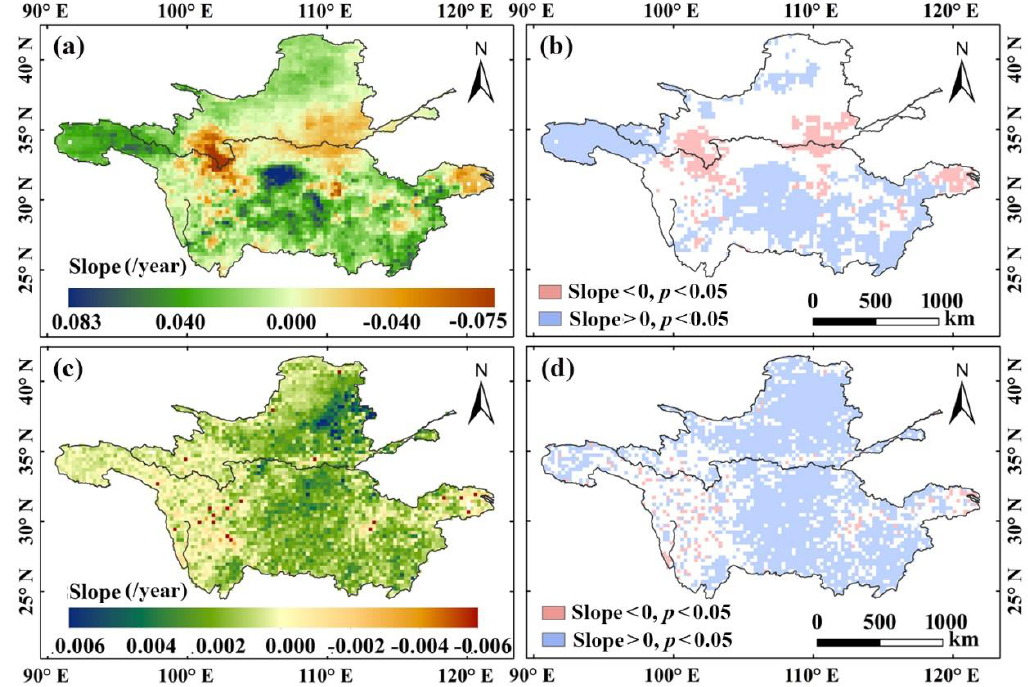
Figure 3. Spatial pattern of the slope and significance of the mean SEDI ( a , b ) and NDVI ( c , d ) of the growing season from 1982 to 2015.